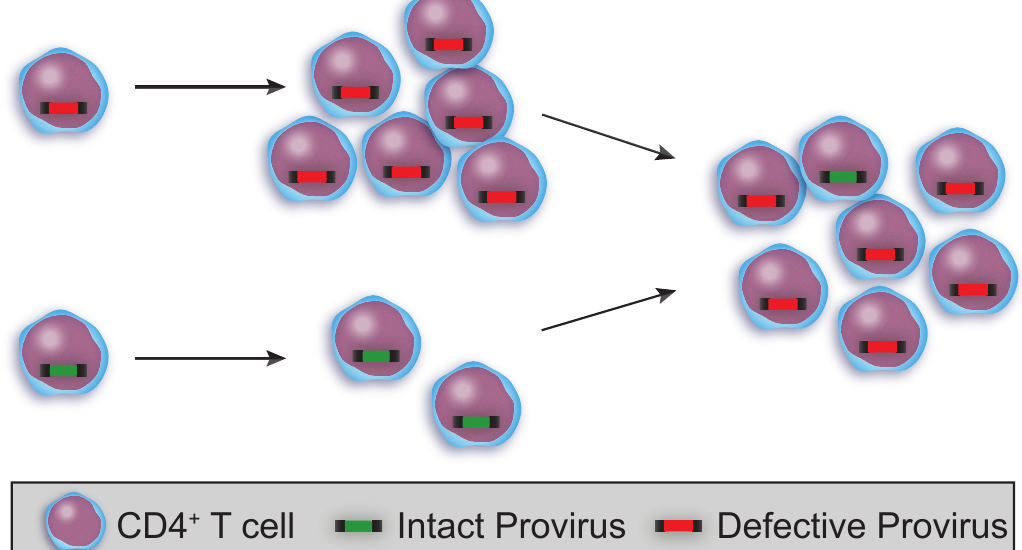
Figure 3. Proliferation of intact and defective proviruses build and maintain the viral reservoir. Cells with intact proviruses (green bar) can sometimes proliferate and expand but do not survive as abundantly as cells harboring defective provirus (red bar) and eventually decrease over time. Proliferation is more abundant for cells with defective